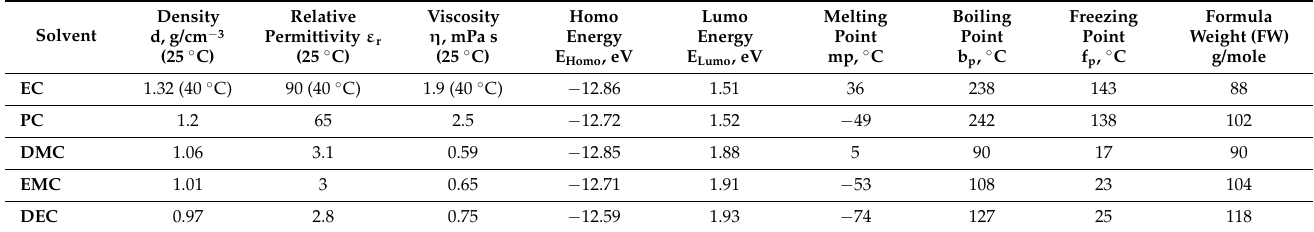
Table 1. Properties of some conventional organic solvents [83].